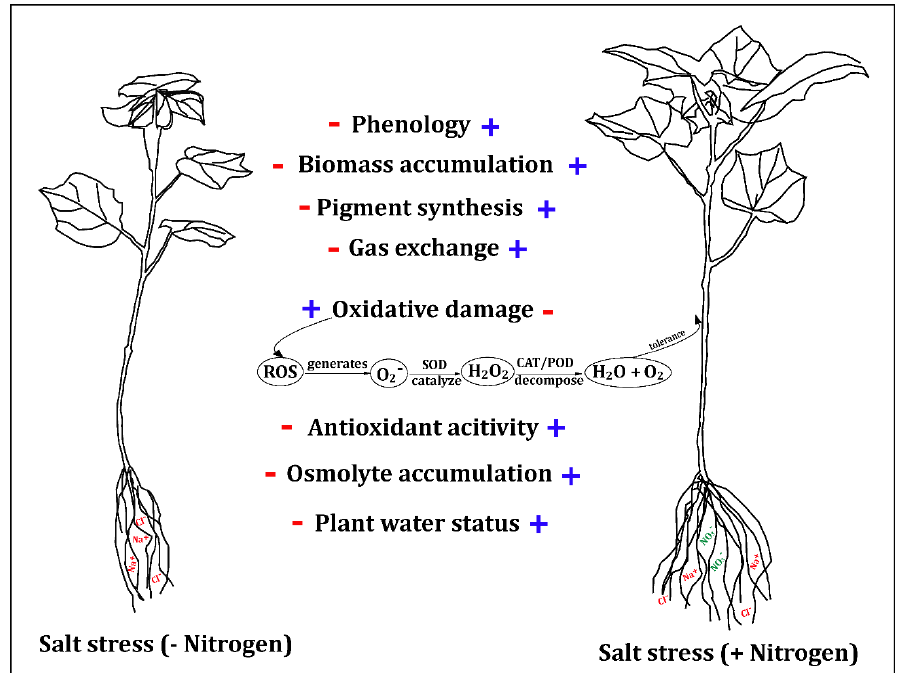
Figure 10. A proposed model for nitrogen interaction with salt stress in cotton seedlings. Salt stress negatively correlated with growth and development by reduces photosynthetic attributes and over production of reactive oxygen species (ROS). Nitrogen supplementation progressively detoxifies the deleterious effect of ROS by stimulating the antioxidant defense system, maintaining better redox homeostasis.